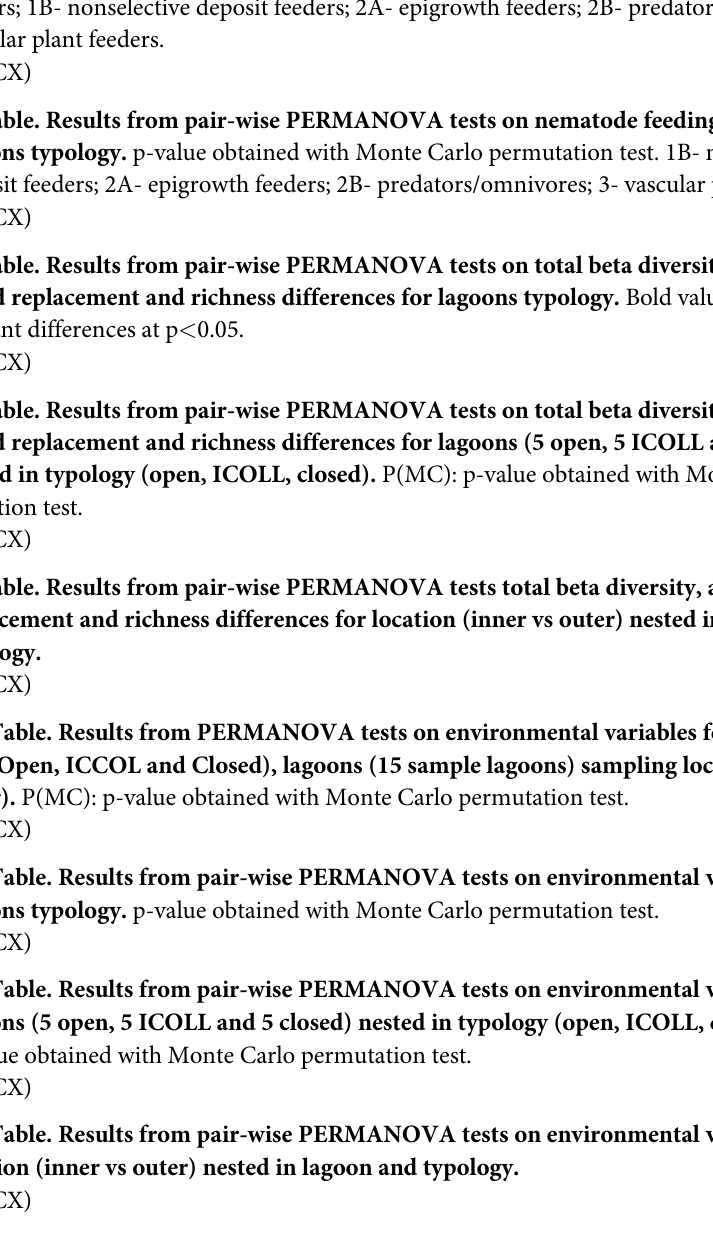
S3 Table. Results from pair-wise PERMANOVA tests on univariate nematode descriptor and nematode assemblages for lagoons (5 open, 5 ICOLL and 5 closed) nested in typology